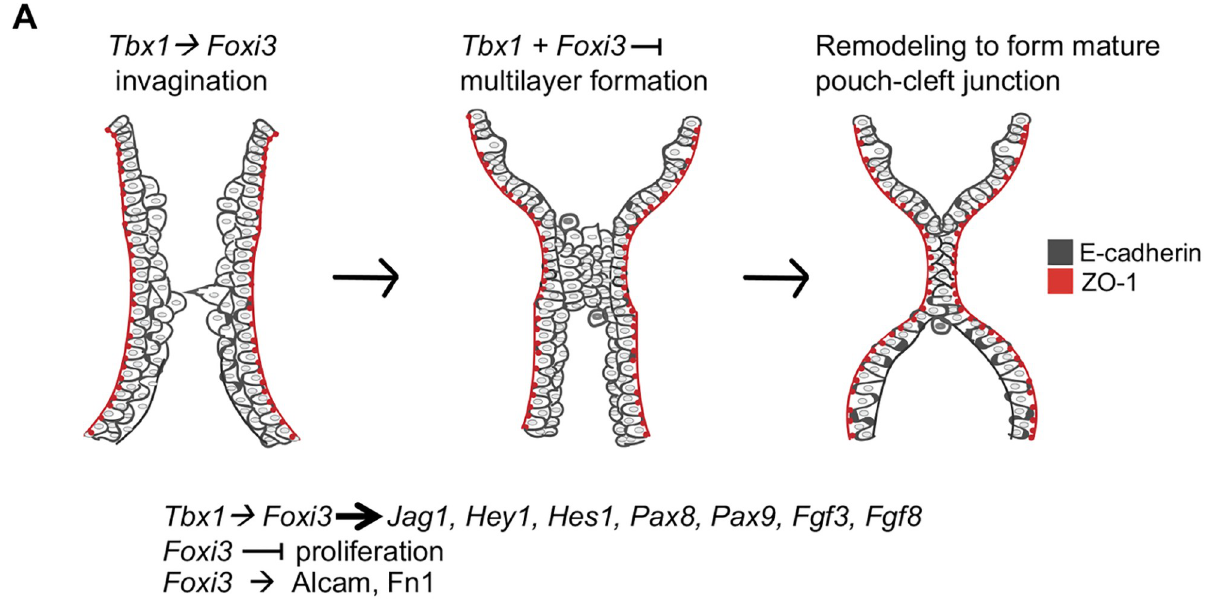
Fig 9. Summary cartoon of Tbx1 and Foxi3 functions in PA segmentation. Cartoon of epithelial cells during PA segmentation for each arch. Tbx1 and Foxi3 are co-expressed where segmentation to individual pharyngeal arches occurs. When segmentation of the distal PA begins at E8.5, invagination of E-cadherin expressing cells (dark gray) is initiated and a partially stratified multilayer of epithelium forms by E8.75-E9.0, near the point where invagination continues. Tbx1 acts upstream of Foxi3 to promote proper invagination as indicated. The outermost cell layer maintains apical/ basal polarity as depicted by ZO-1 expression (red), while the inner layers do not. The epithelial cells begin to project towards each other as shown. Next, a multilayer is juxtaposed where invagination has advanced, and a zippering process ensues from the center of the region, where cells are reorganized. Finally, a dual-layer of intercalated epithelial cells are formed at the mature pouch-cleft junction and both arches are separated. Foxi3 appears to inhibit excess proliferation of PE cells early, while Tbx1 doesn’t alter proliferation. In Tbx1 null mutant embryos more cells are present in the shortened PA. Inactivation of Tbx1 or Foxi3 results in the appearance of excessive layers of endoderm cells, in particular, where invagination is initiating. Therefore, these genes might both promote invagination and restrict excessive multilayers during PA segmentation. We found that Tbx1 and Foxi3 may act in the same pathway upstream of some Notch pathway genes, Pax8 and Pax9 , as well as Fgf3 . Some of these genes might be required pharyngeal segmentation. It is previously known that Tbx1 and Foxi3 act upstream of Fgf8 . While loss of Foxi3 resulted in reduction of Alcam and Fibronectin expression in the extracellular matrix, global loss of Tbx1 did not have the same role. Thus, this data explains, in part, the basis of the genetic interaction between the two genes.